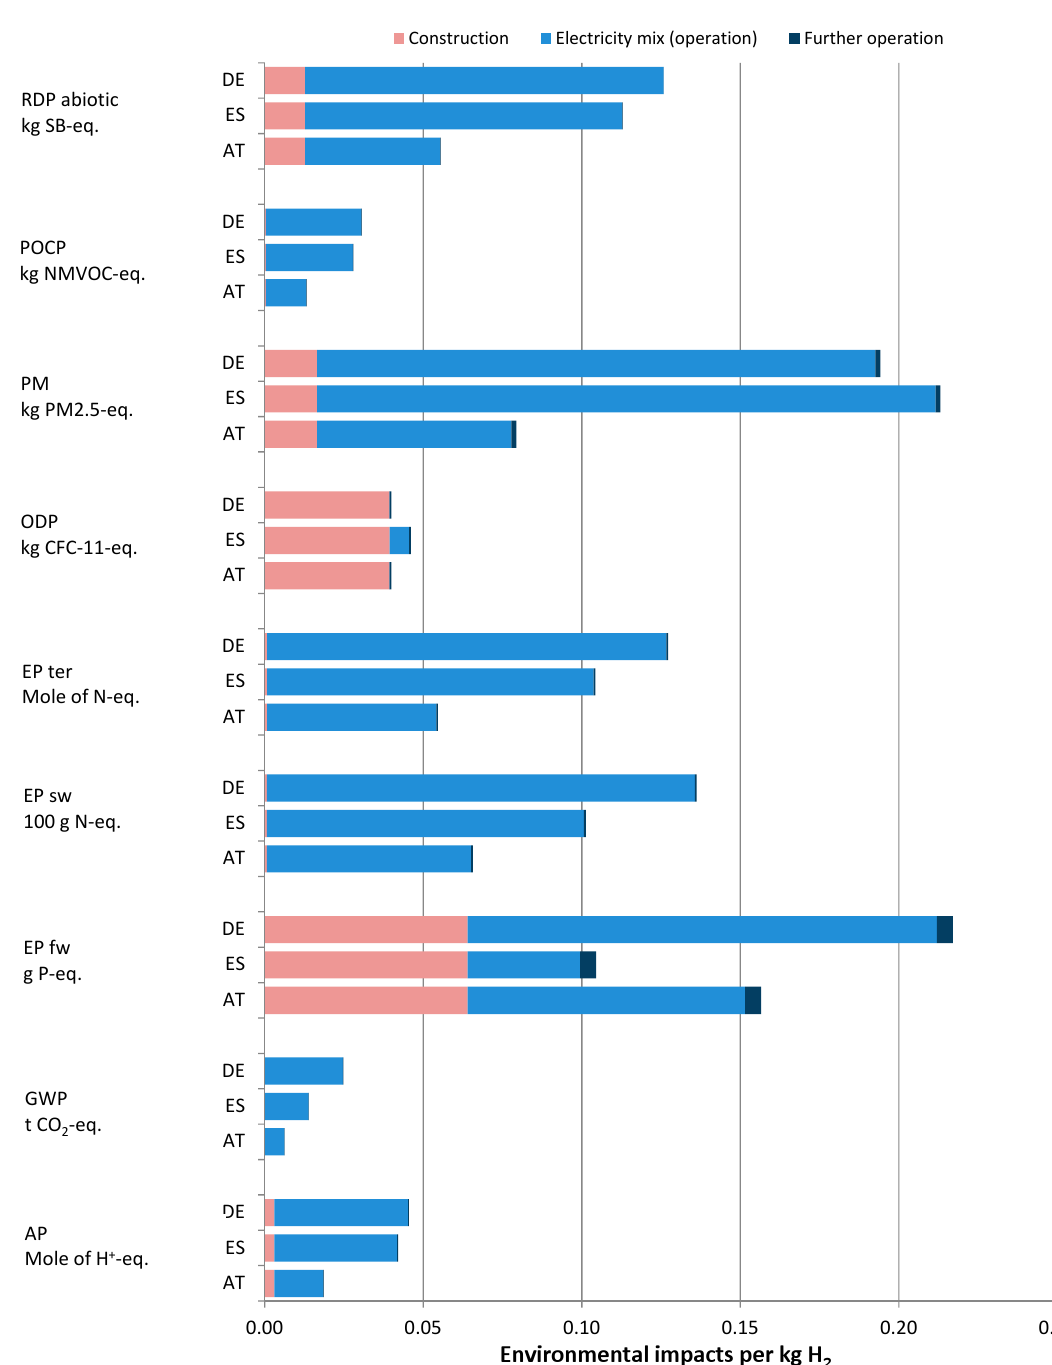
Figure 3. Share of life cycle stages on the impact categories at different sites of operation.